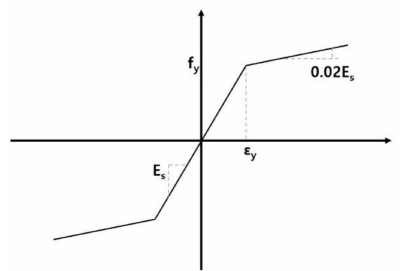
Figure 5. Constitutive model for steel